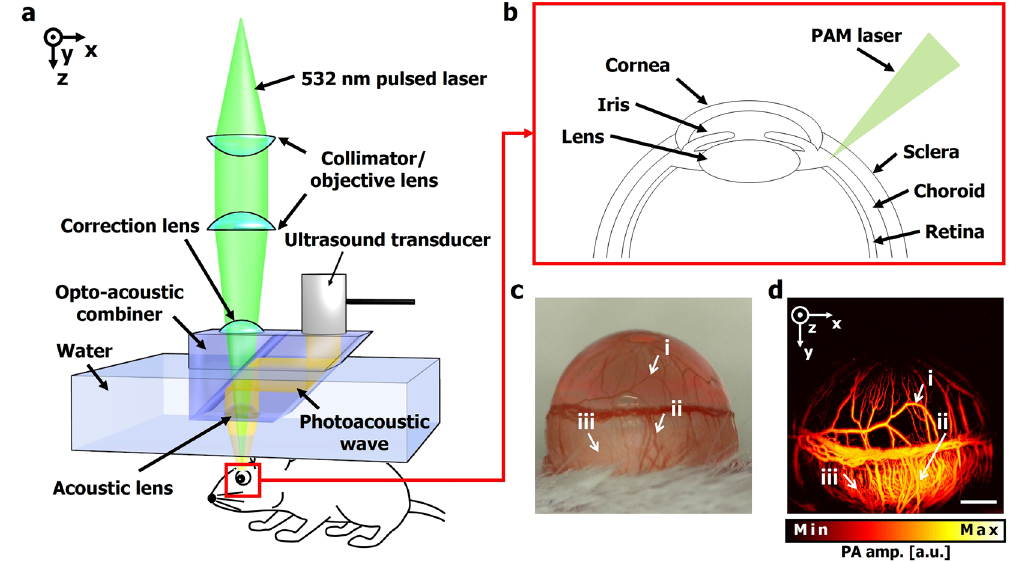
Figure 1. ( a ) Schematic of an optical-resolution photoacoustic microscopy (OR-PAM) system. ( b ) Diagram of a mouse eye. ( c ) Photograph (left) and PA MAP image (right) of a mouse eye. Scale bar: 500 μ m. PA, photoacoustic; MAP, maximum amplitude